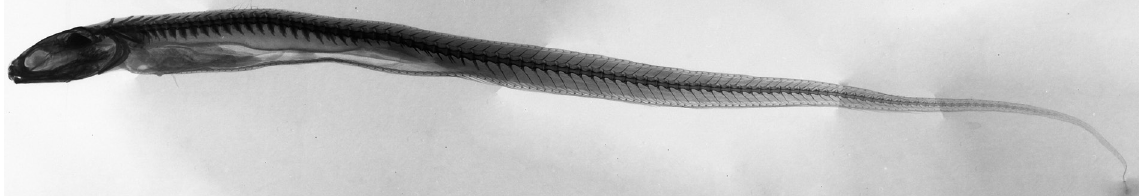
Fig. 3. Echiodon prionodon sp. nov., left lateral X-ray (holotype NMNZ P.041833, 165 mm